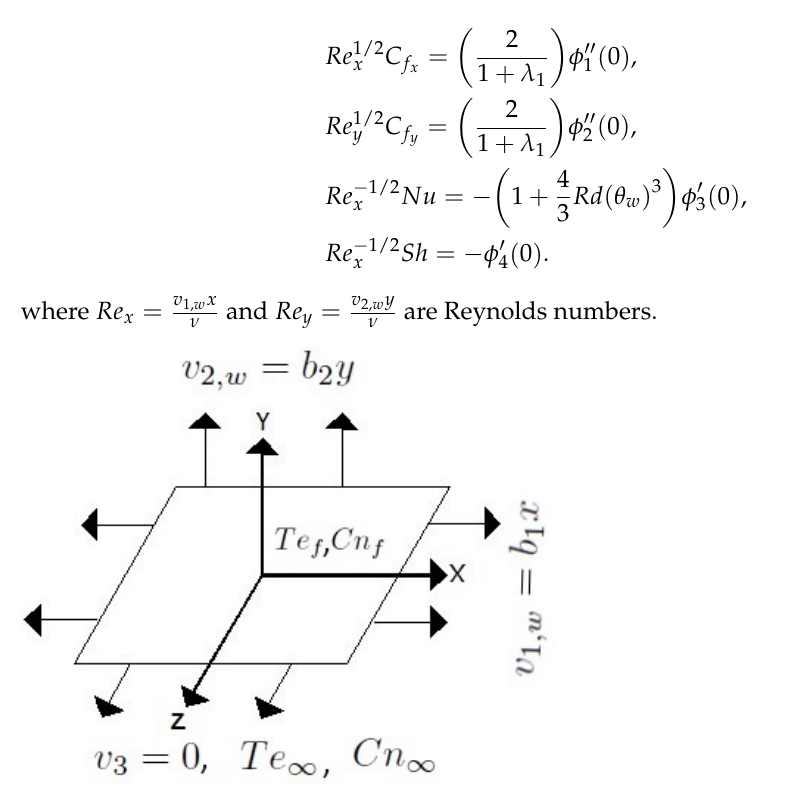
Figure 1. Physical